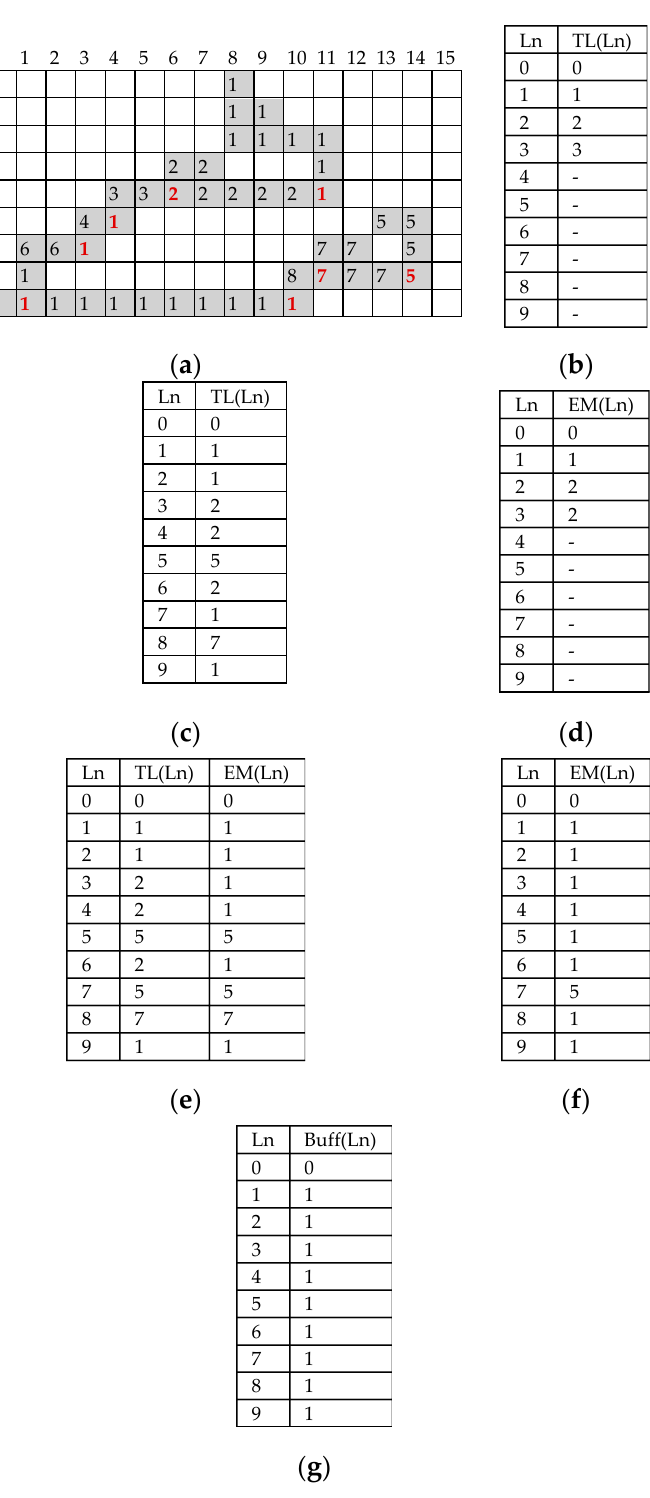
Figure 3. Example of CCL: ( a ) the input binary image; ( b ) content of translator LUT (TL) when P (4,6) is reached; ( c ) content of TL at the end of the first scan; ( d ) content of equivalence memory (EM) when P (4,6) is reached; ( e ) content of TL and EM when P (8,10) is reached; ( f ) content of EM at the end of provisional labeling; ( g ) content of buffer memory (BUFF).